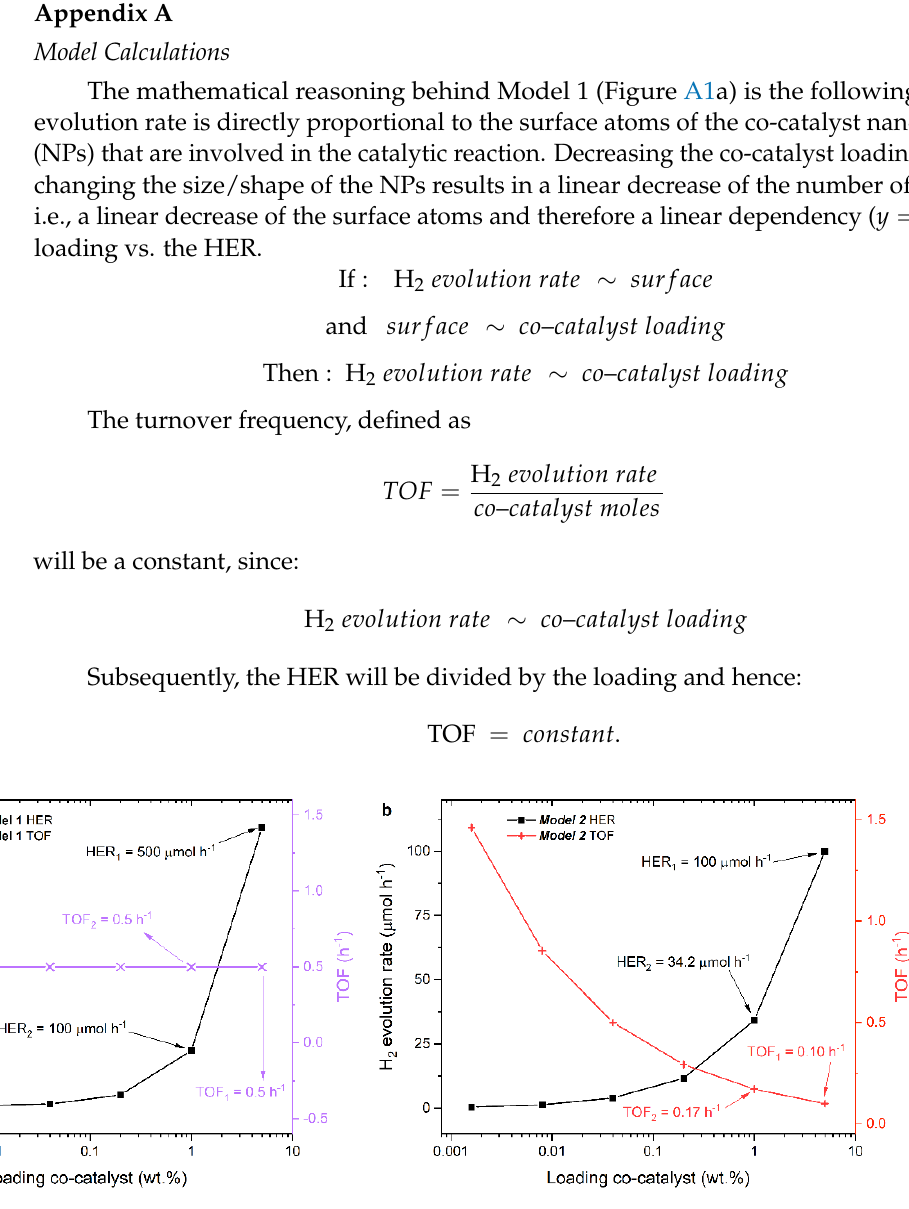
Figure A1. Graphical representations for ( a ) Model 1: loading vs. HER (black slope, y = x ) and loadings vs. TOF (purple constant, y = a ) and ( b ) Model 2: loading vs. HER (black line, y = x 2/3 ) and loading vs. TOF (red line, y = x − 1/3